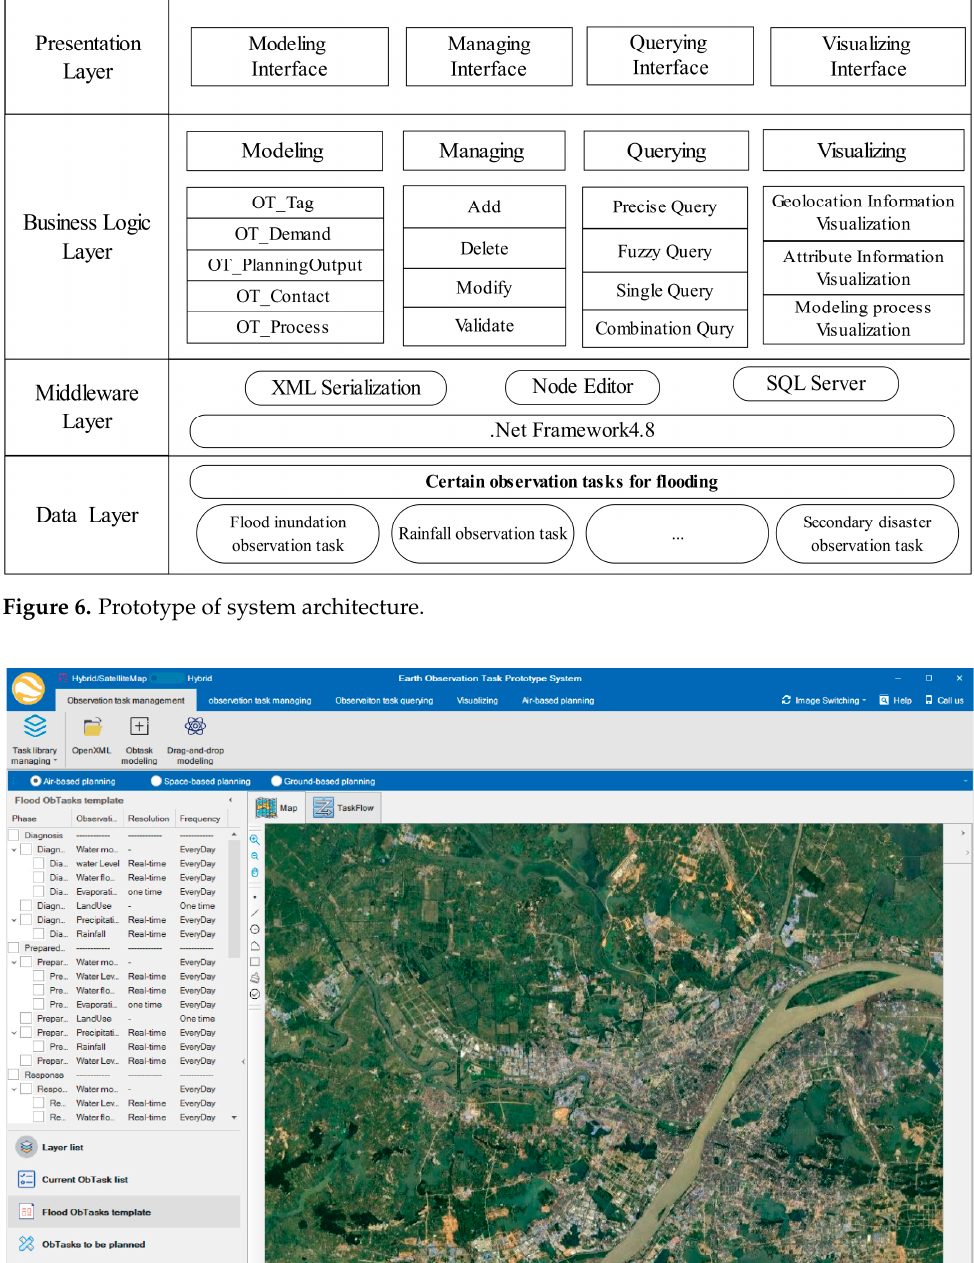
Figure 8. Interface of earth observation task modeling. 3.2. Flood-Oriented Earth Observation Task Experiments 3.2.1. Experiment Background Wuhan (113°41 ′ –115°05 ′ E, 29°58 ′ –31°22 ′ N), the capital city of Hubei Province, is lo- cated in the eastern section of the Jiang-Han Plain (Figure 9a,b). It is threatened by the highest fl ood risk in the Yang tz e River basin, receiving an average annual rainfall of 1260.9 mm. The rainy season in Wuhan in 2016 was from 18 June to 21 July, with particularly strong rains from 30 June to 6 July, causing signi fi cant fl oods and economic damage.